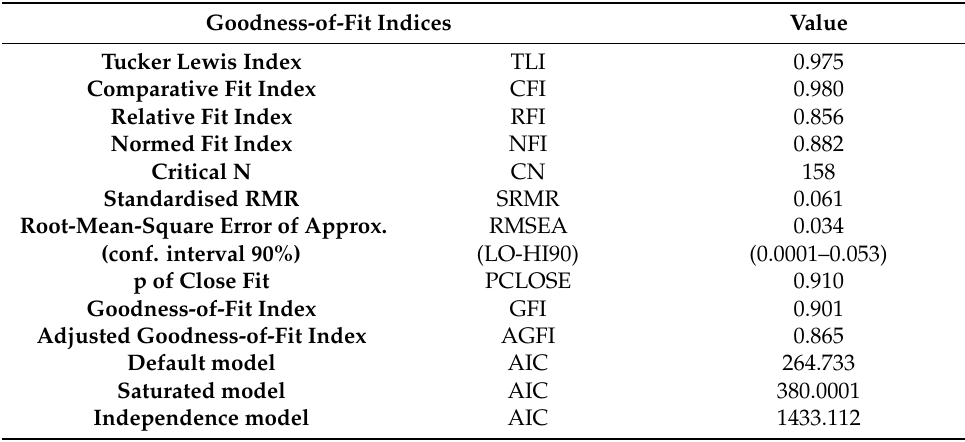
Table 13. Goodness-of-fit indices for the research model of social